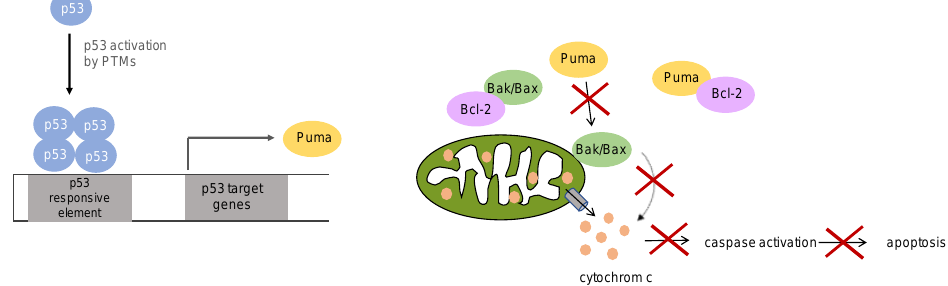
Figure 2. Function of p53 upregulated modulator of apoptosis (Puma) in apoptosis: After activation of p53, its target gene Puma is transcribed. Puma functions in mediating apoptosis through indirect activation of Bcl2 associated X/Bcl2 antagonist/Killer (Bax/Bak) through inhibiting Bcl-2 family member proteins or through direct activation of Bax/Bak, which mediate mitochondrial outer membrane permeabilization and thereby releasing cyctochrome c and activating apoptosis. Puma plays a critical role in mediating p53 mediated induction of apoptosis and non-functional Puma will lead to an obstructed apoptosis.